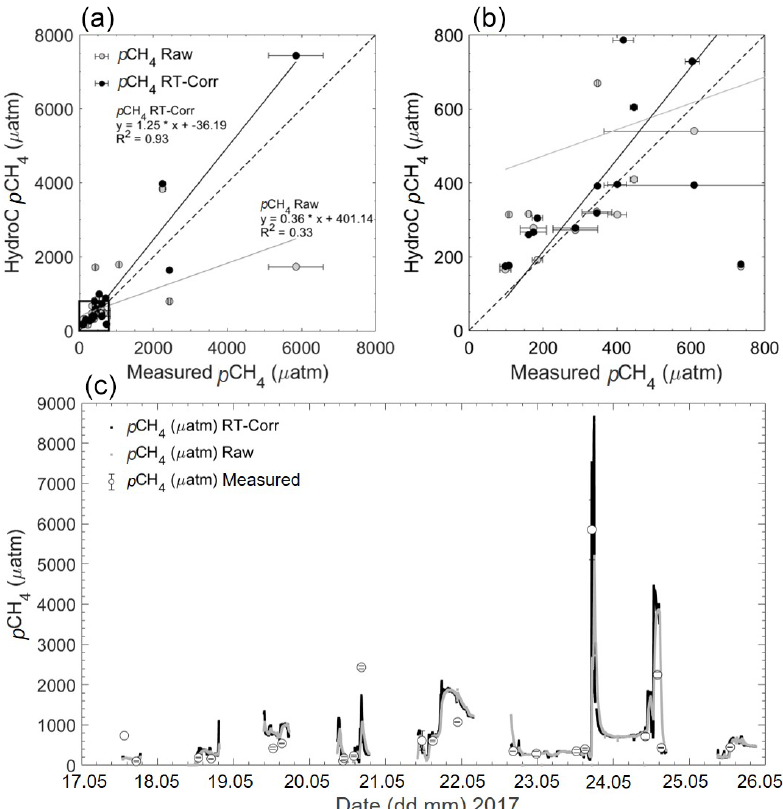
Figure 9. (a) Rom1 p CH 4 µatm data versus measured discrete samples of p CH 4 µatm, with both raw HC–CH 4 data and response time corrected (RT-Corr) data over the full range of concentrations. (b) A close-up view of the lower 800µatm, with errors for the measured samples against the HC–CH 4 data. The grey line signals the line of best fit for the raw p CH 4 , and the black line signals the RT-Corr p CH 4 µatm. (c) The full transect with discrete p CH 4 µatm samples for the spring cruise over time (date in dd.mm), but some error bars are too small to